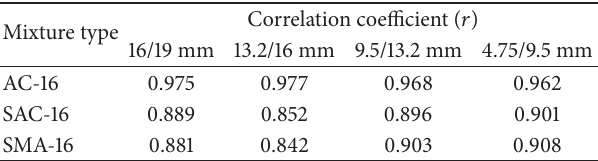
Table 6: Correlation analysis results between fractal dimension of coarse aggregates and maximum shear stress of asphalt